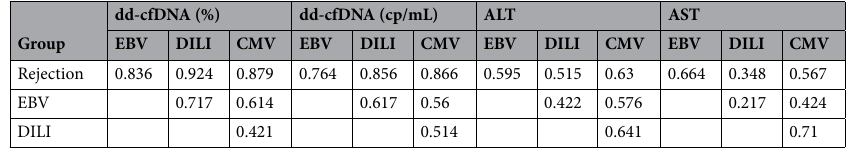
Table 4. Comparative analysis of different subgroups of AUC values. DILI drug-induced liver injury, EBV Epstein–Barr virus, CMV cytomegalovirus, dd-cfDNA donor-derived cell-free DNA, ALT alanine aminotransferase, AST aspartate aminotransferase.